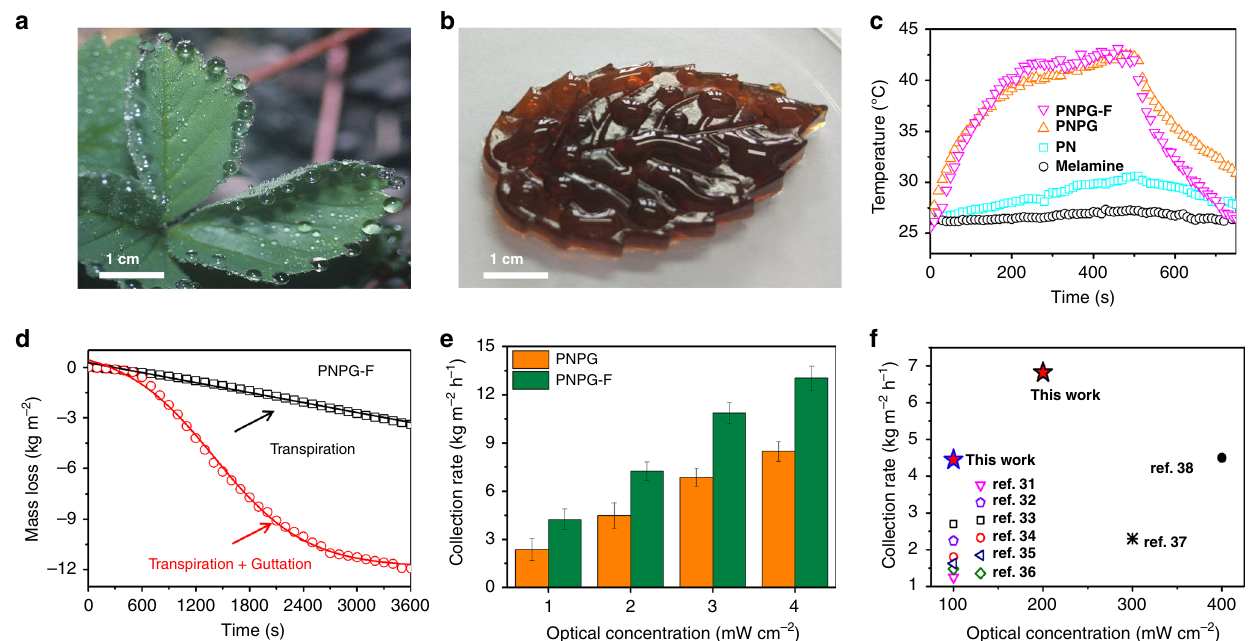
Fig. 3 Appearance and water harvesting performance of the PNPG-F puri fi er. a Optical image of guttation of natural plant leaves. b Guttation phenomenon of the PNPG-F puri fi er. c Plots show the surface temperature of various samples under 1-sun irradiation at various time points. d The mass change of water with PNPG-F under 1-sun irradiation. e The water collection rate of PNPG and PNPG-F under various optical concentrations. Error bars were determined based on the standard deviation measured multiple times. f Comparison of water harvesting performance of the PNPG-F puri fi er and the previously reported word under various optical energy densities. Source data are provided as a Source Data fi